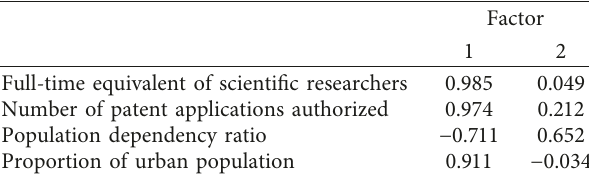
Table 4: Factor composition